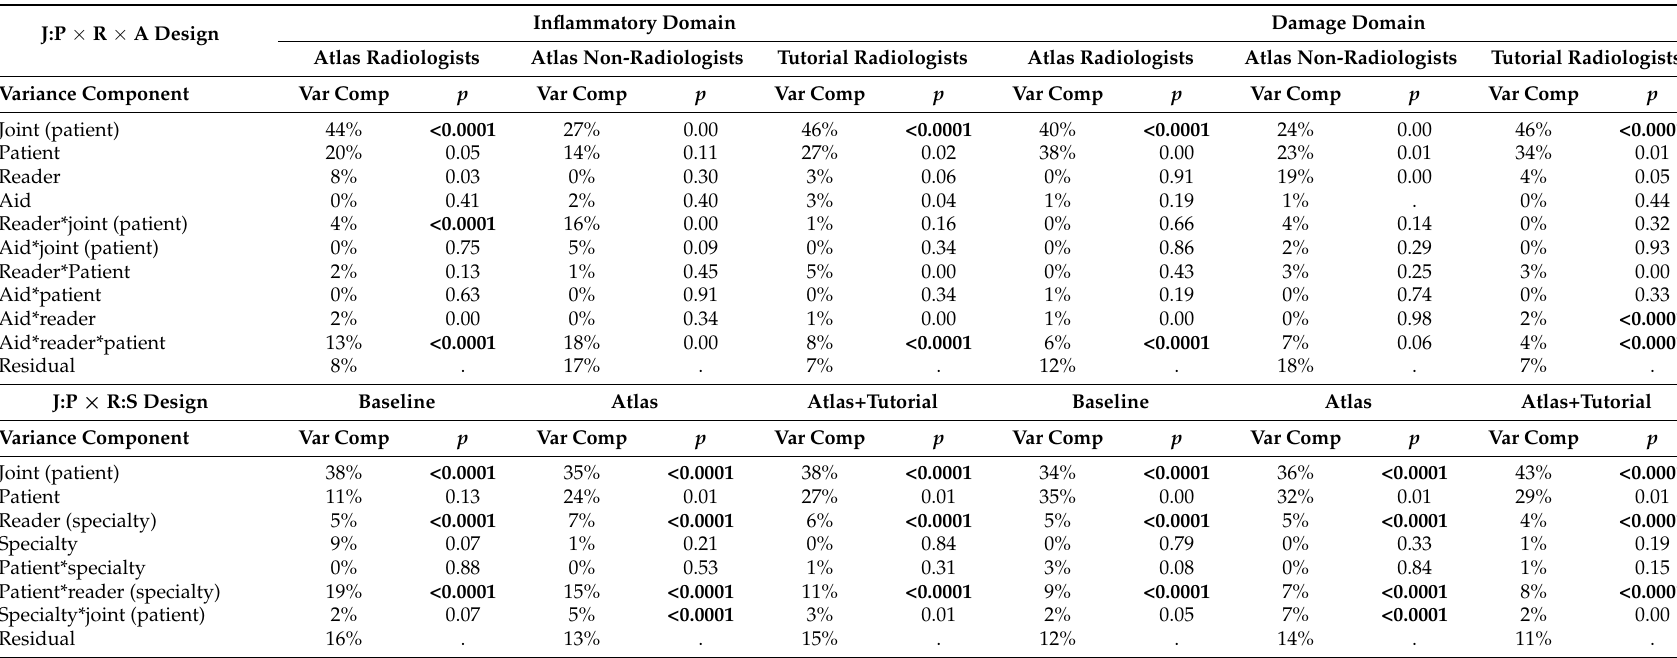
Table A4. Analysis of the JAMRIS-TMJ scores by multiway ANOVA, where all effects are modeled as random. In the J:P × R × A design (top half), the effects of three factors, patient, aid, and reader on the joint score are analyzed by combining the 1A and 1B datasets under the atlas column, and the 2A and 2B datasets under the tutorial column from the radiologists. In the J:P × R:S design, the effect of patient, reader and specialty are analyzed by combining the 1B and 2A datasets for the atlas row, and 2B and 3 datasets for the tutorial row, with 1A as baseline. Bolded p values are those which remained significant after applying Bonferroni correction for multiple